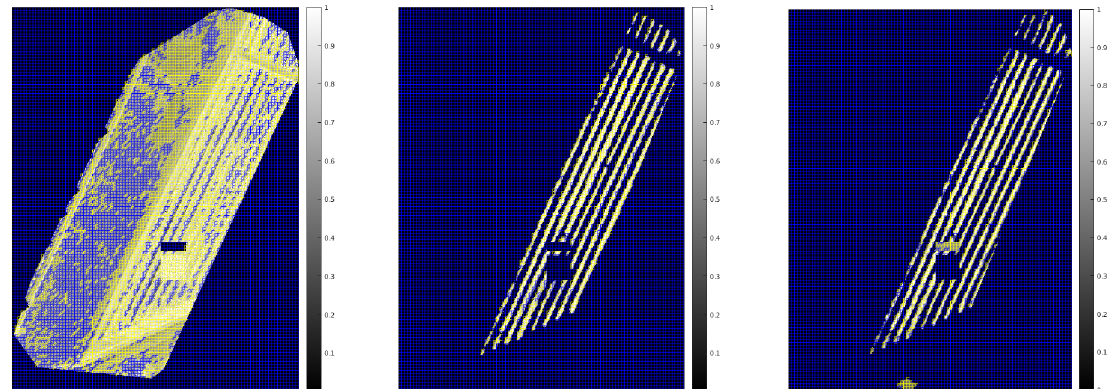
Figure 15. ( left ) The CNN tile regions identified for the artifact NDVI radiometric index in Figure 14 ( left ) clearly identifies crop regions as well as non crop regions along the borders with high probability as crops. ( centre ) The CNN tile regions identified for the DSM/NDVI regularized radiometric index defined by Equation (14) identifies the crop field correctly. ( right ) The DSM for the ( top right ) the CNN tile regions identified for the artifact DSM data in Figure 14 ( right ) clearly identifies crop regions as well as the man-made structure with high probability as crops.